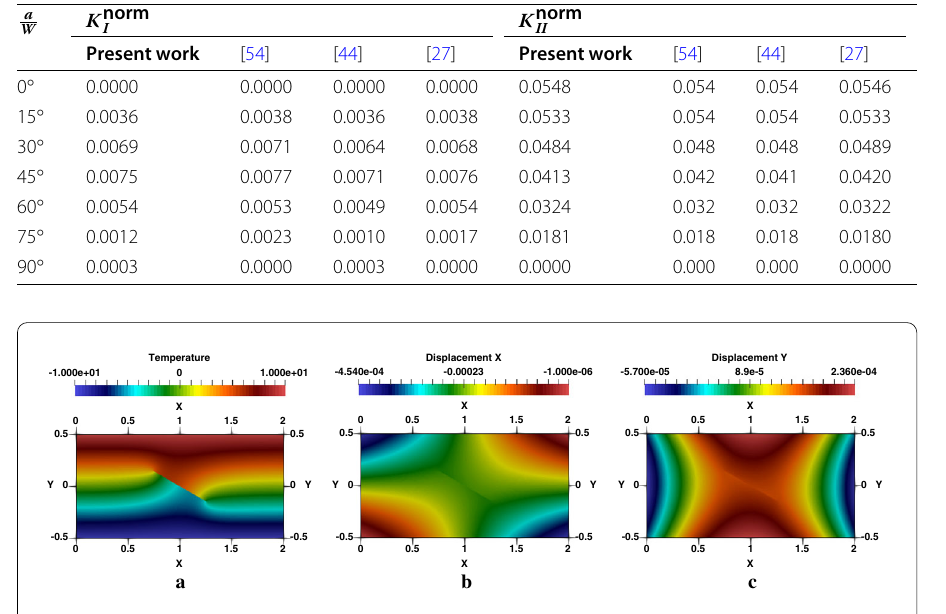
Table5 Normalized SIFs for slope crack at both tips, a / W = 0 . 3 and various β